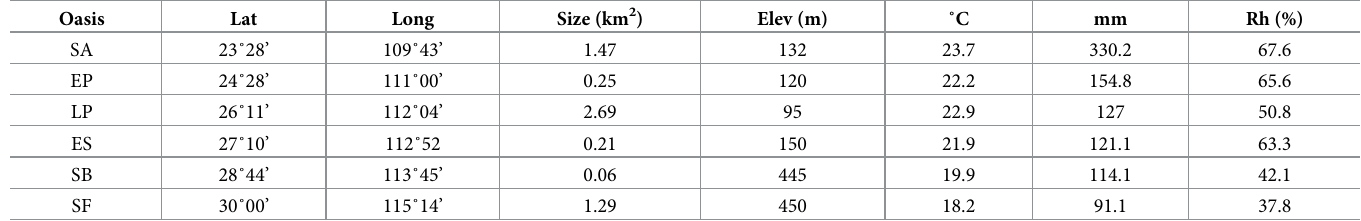
Table 1. Sampled localities along the Baja California peninsula. SA = Santiago, EP = El Pilar, LP = La Purı´sima, ES = El Sauzal, SB = San Borja, SF = San Fernando. Temperature (˚C), precipitation (mm), and relative humidity (Rh) were obtained from SMN [38]. Size was extracted from maps from INEGI [39].